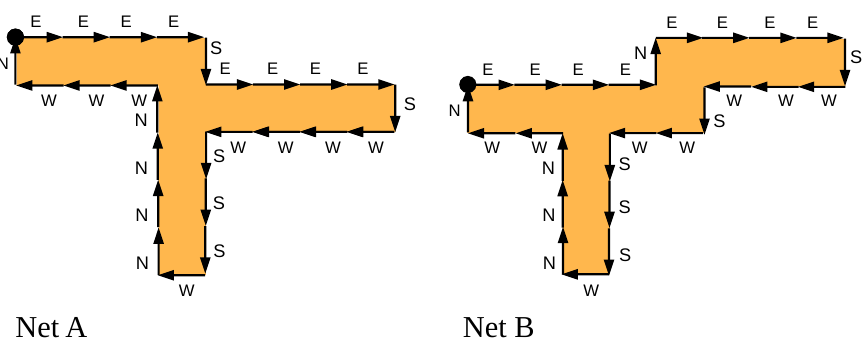
Figure 3. The nets from Figure 2 with their borders encoded as sequences of symbols starting from the top-left corner (black dot).